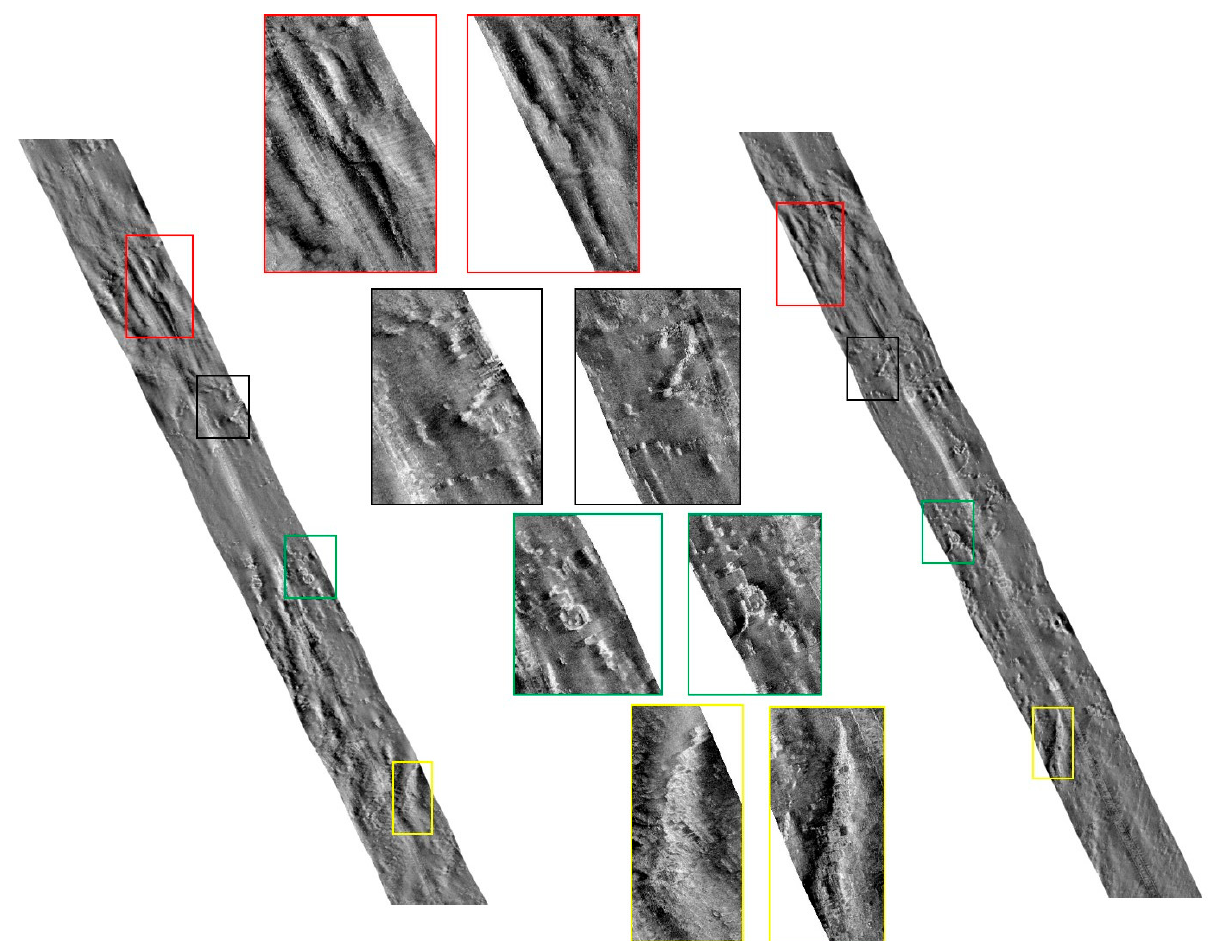
Figure 3. Two strips used for verification. Four image pairs with obvious common features were selected.